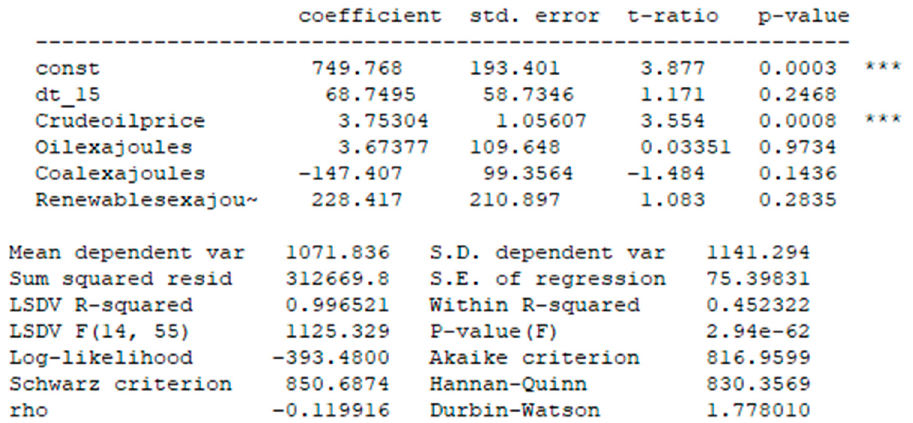
Figure 14. Equation e ff ects that our chosen variables had on GDP.